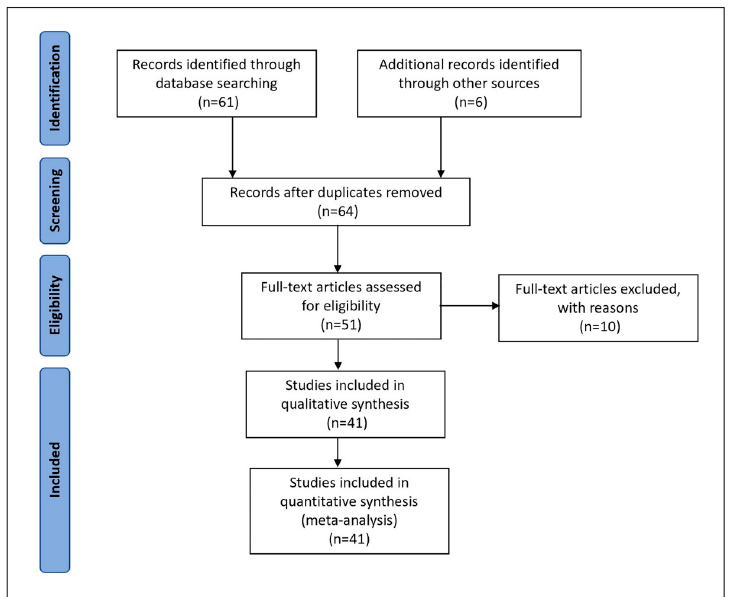
Fig 1. Flow chart with studies included in the systematic